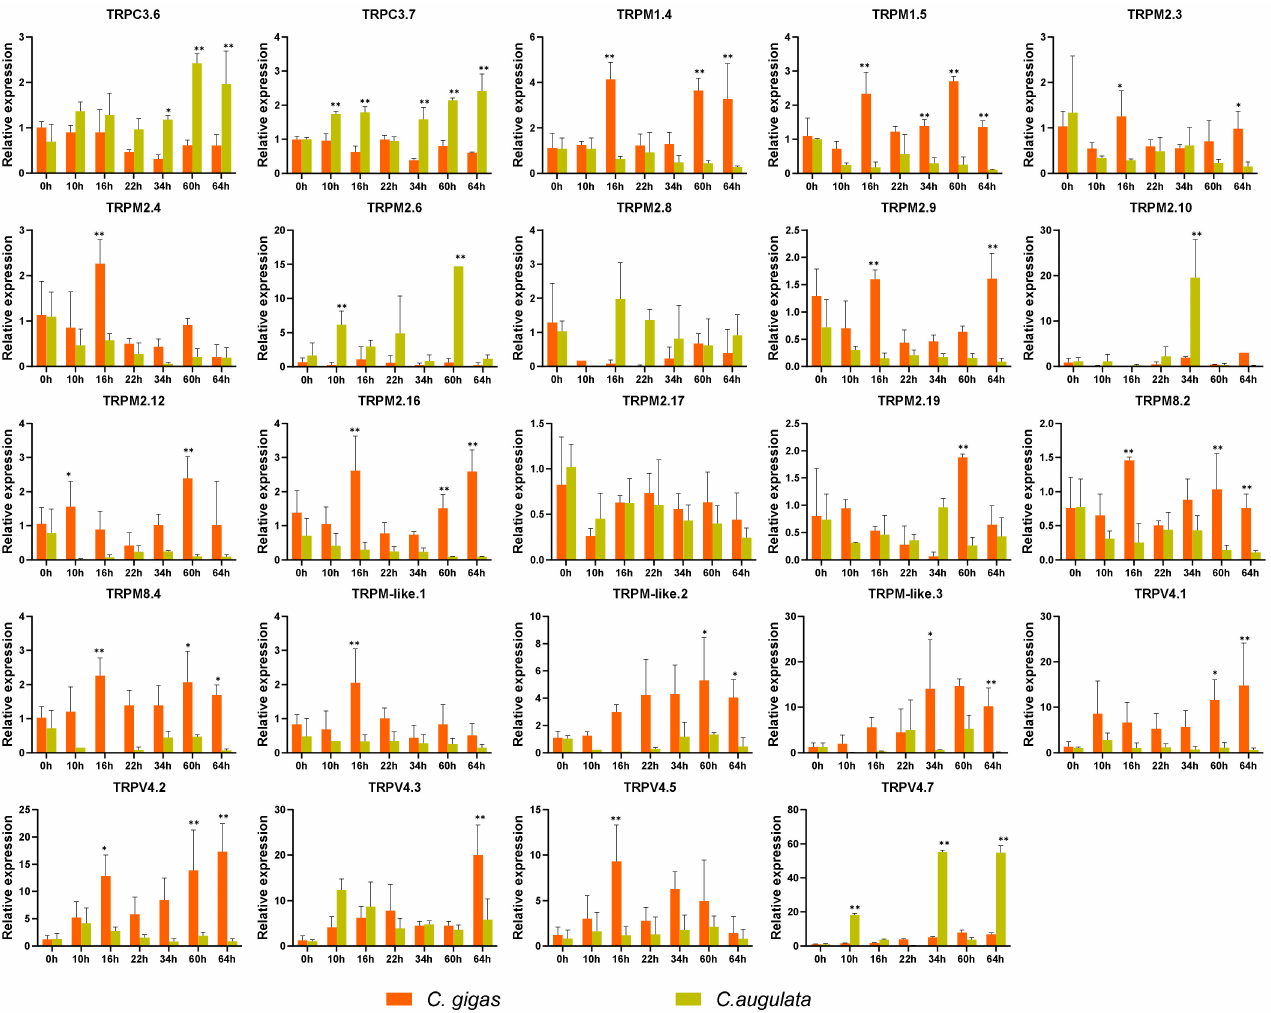
Figure 5. Relative expression of TRP genes between C. gigas and C. angulata after chronic heat stress. The Y-axis represents relative expression as normalized expression levels of the elongation factor 1 alpha (EF1 α ) gene. Each value of relative expression was shown as mean ± S.E. ( n = 3). Asterisks indicate statistical significance (* indicates p < 0.05 and ** indicates p < 0.01)